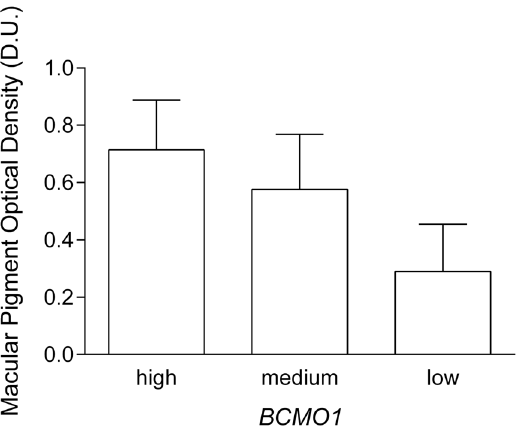
Figure 4. MPOD as a function of ‘‘high conversion’’ (high) (rs11645428 AA/rs6420424 GG/rs6564851 TT), ‘‘low conver- sion’’ (low) (rs11645425 GG/rs6420424 AA/rs6564851 GG) and ‘‘medium conversion’’ (medium) (rs11645425/rs6420424/ rs6564851 remaining genotypes) triple genotypes (error bars indicate + SD). Healthy participants with the ‘‘high conversion’’ genotype had significantly higher MPOD compared with the ‘‘low conversion’’